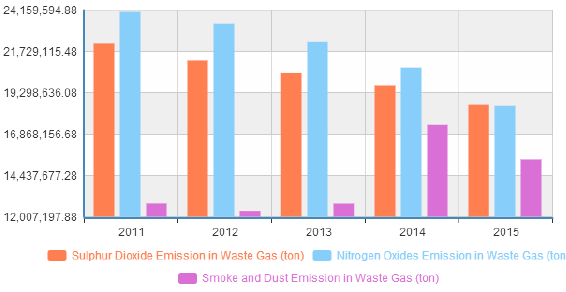
Figure 11. The waste gas discharged (1000 tons) in China.